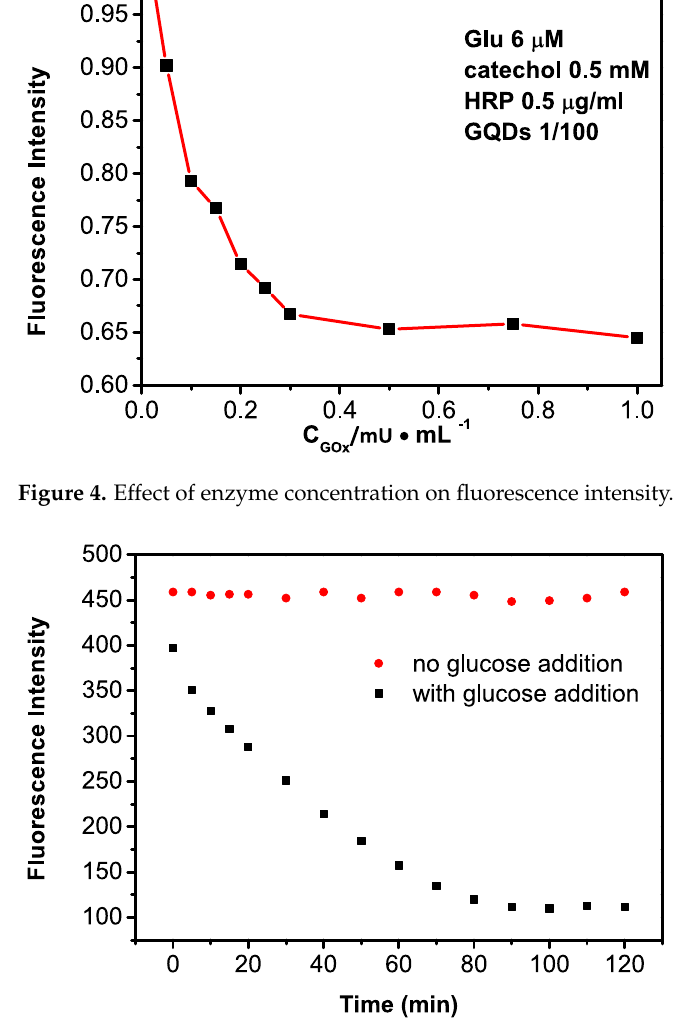
Figure 5. The relationship between fluorescence intensity of the GQDs and the incubation time in the: presence of glucose (Black); and absence of glucose